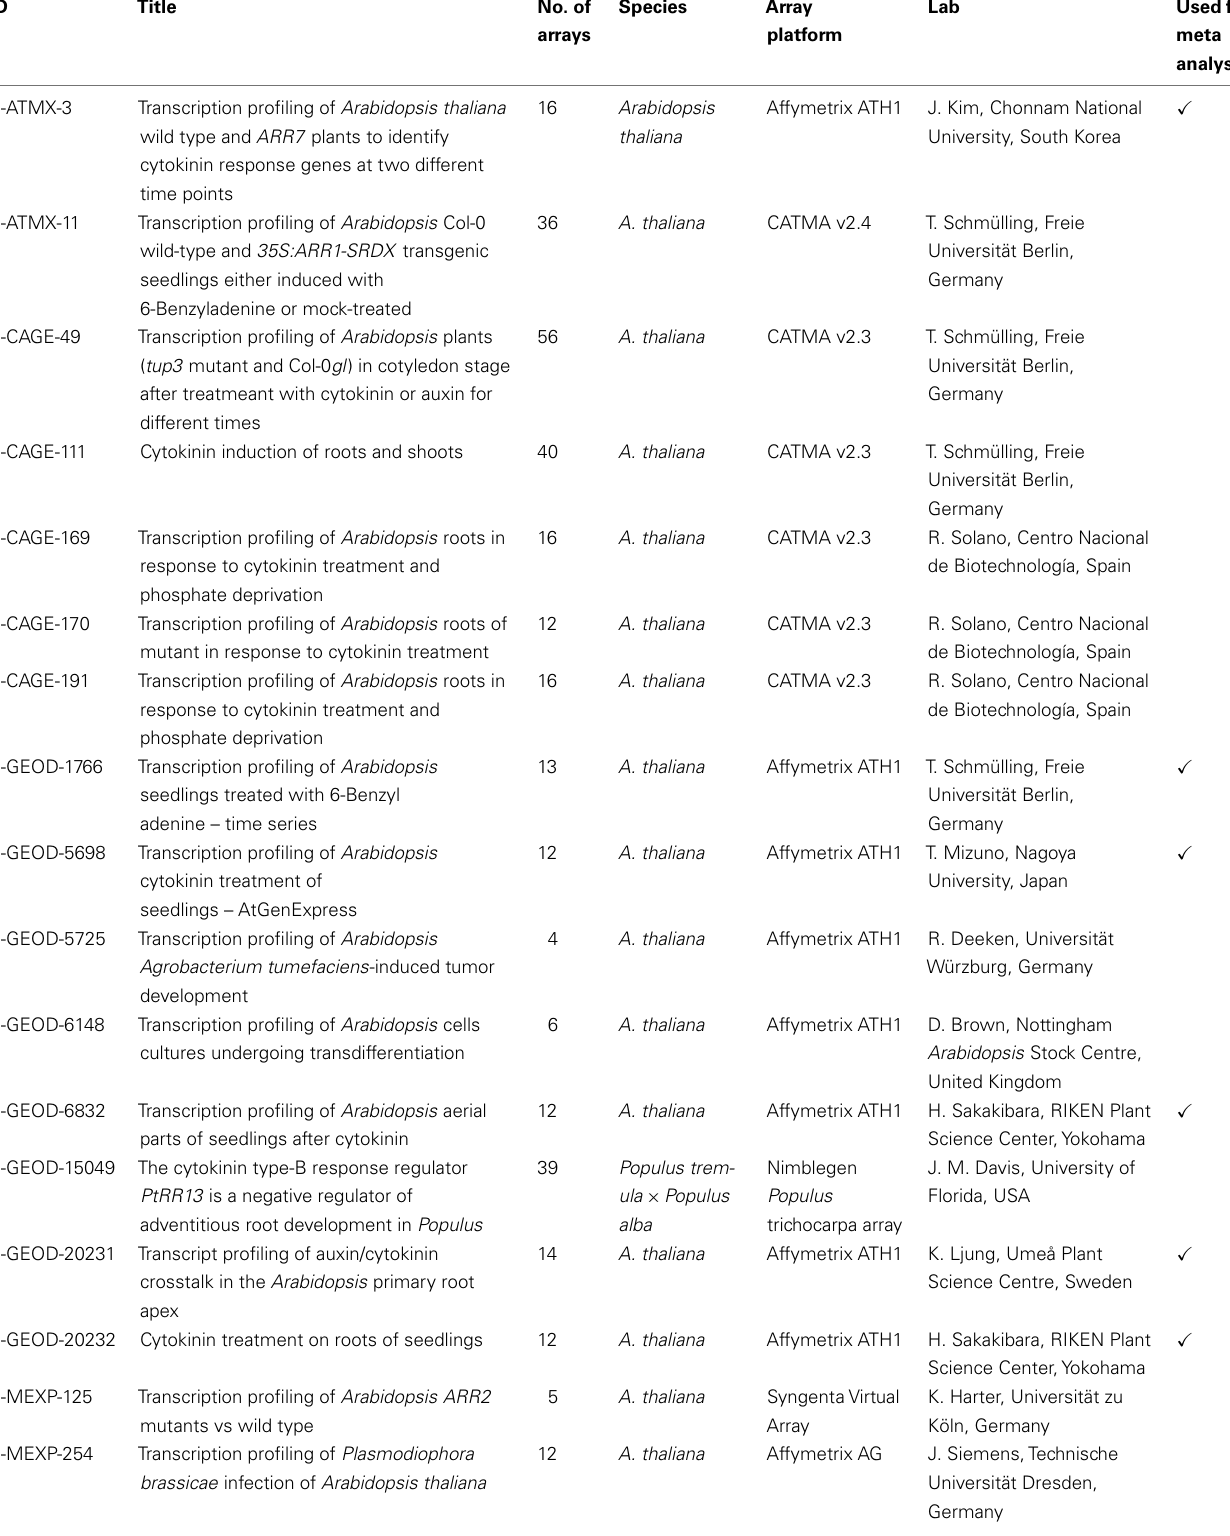
Table 2 | Cytokinin-related microarray datasets in theArrayExpress